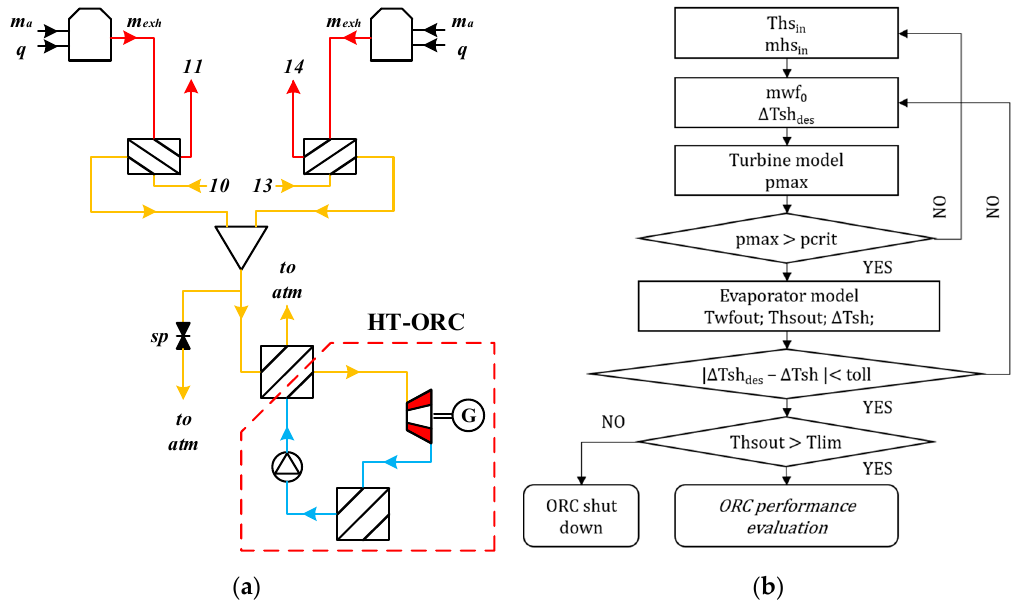
Figure 4. HT–ORC and bottoming system layout ( a ) and off-design ( b ).